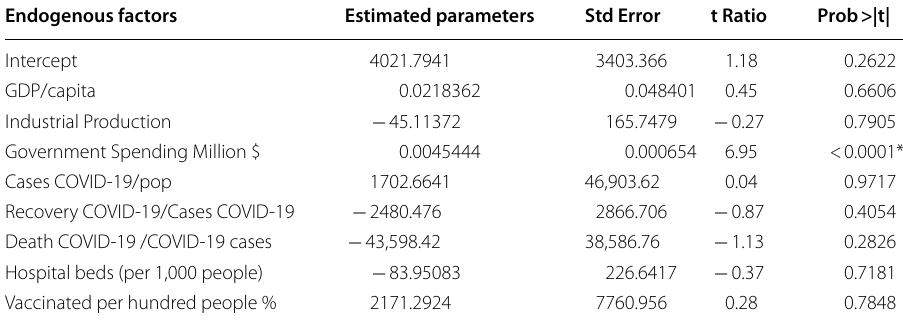
* p ‑value < 0.0, signficant variable